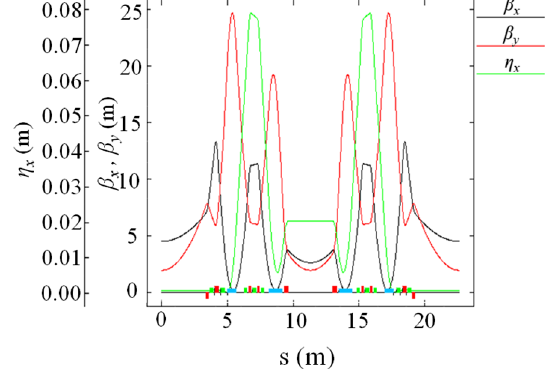
FIG. 2. Optics function of the DDBA cell for the complete ring upgrade of Diamond.